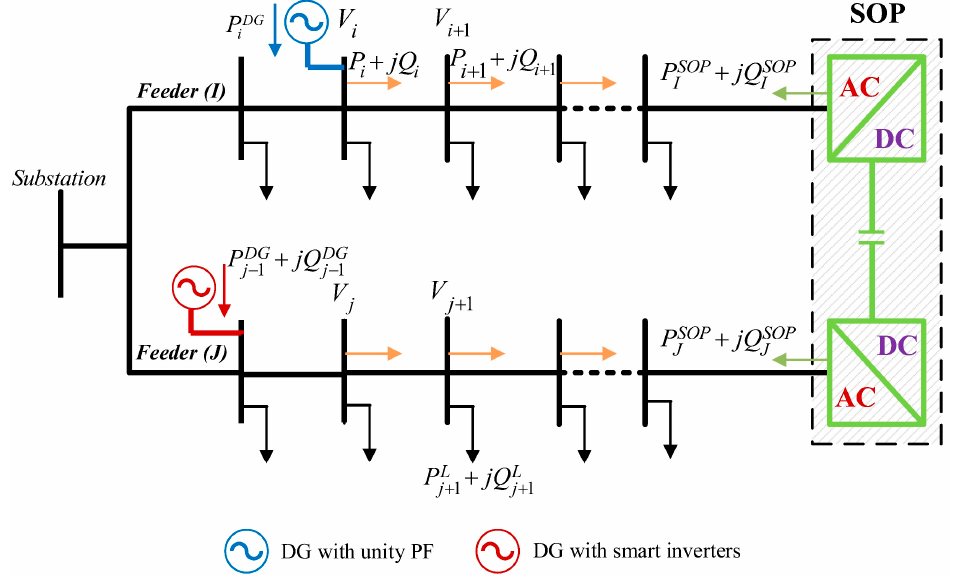
Figure 1. Illustration of SOPs’ integration into a distribution system.